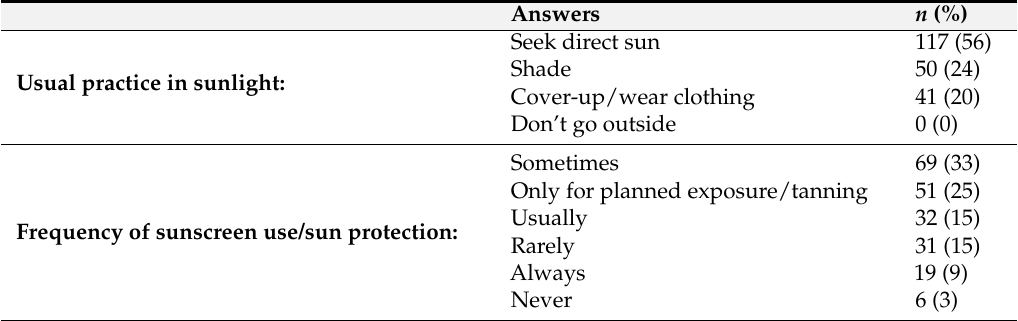
Table 3. UK participants’ sun exposure practices from March/April to September ( n = 208, one participant did not respond). Answers n